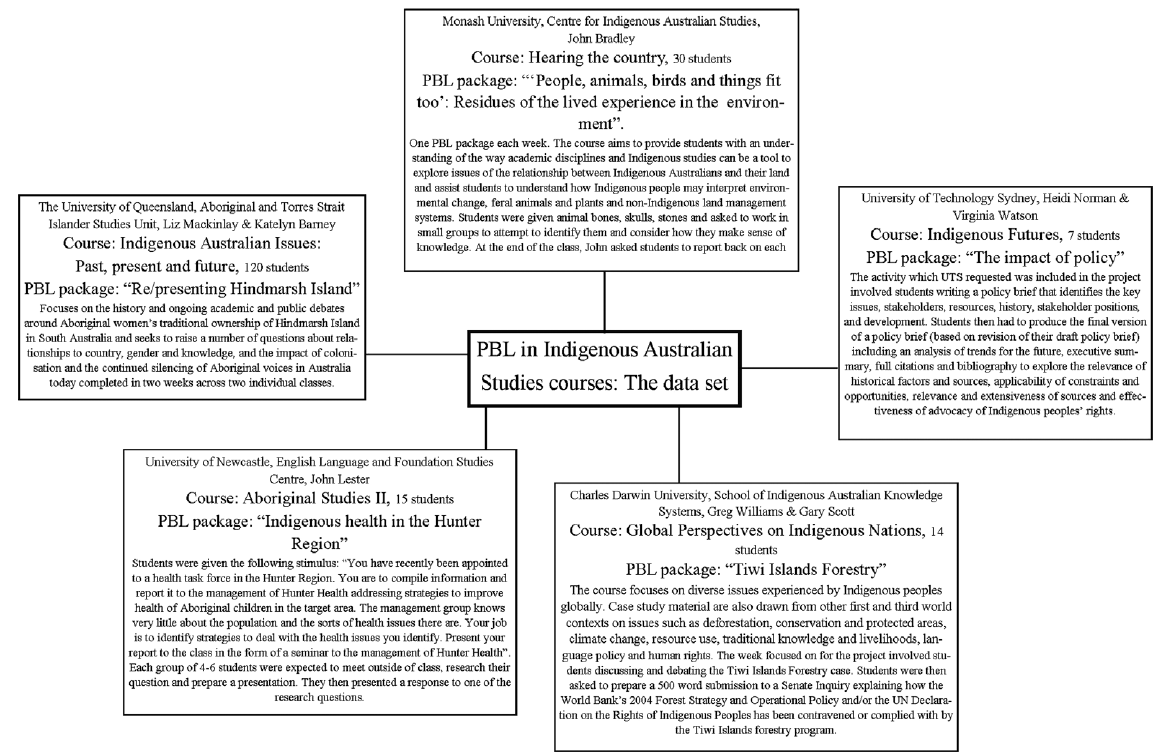
A visual summary of the five case